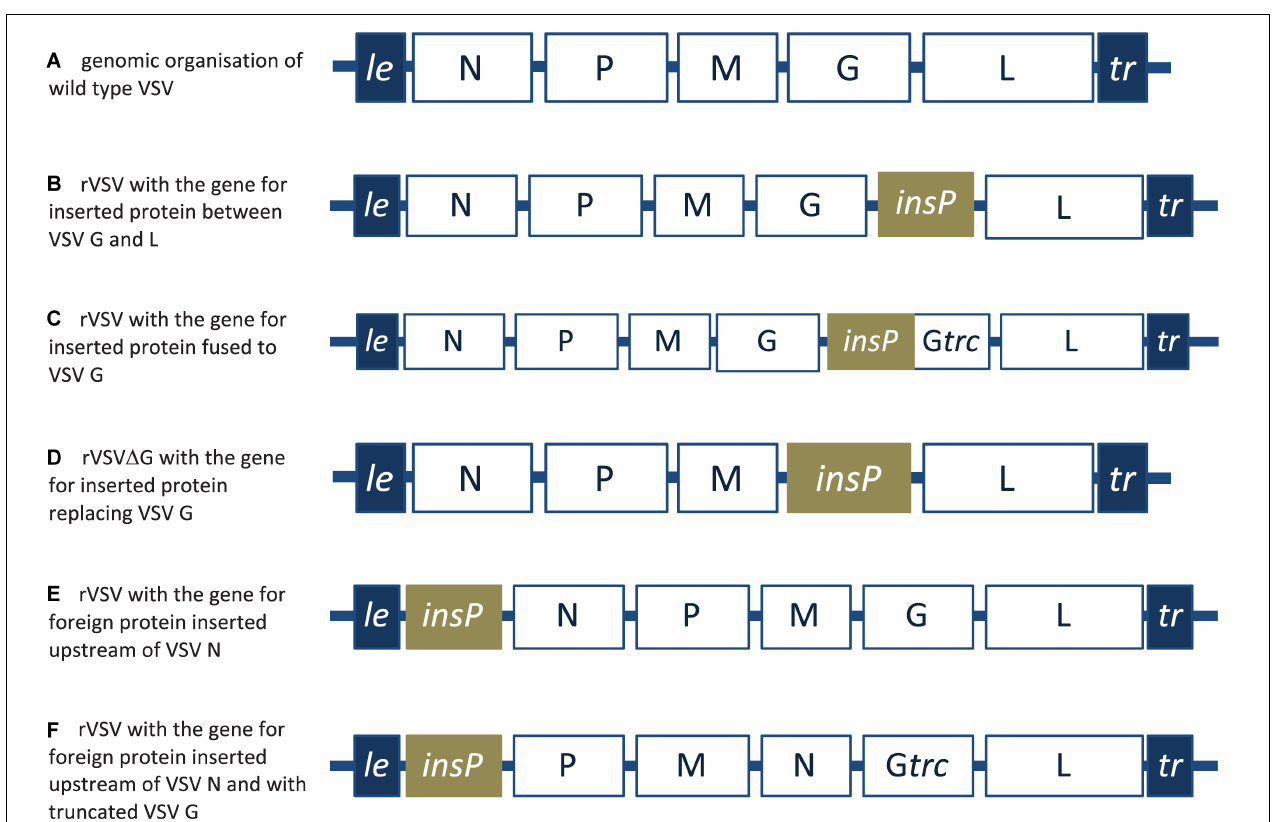
FIGURE 6 | A schematic representation of wild type VSV and recombinant VSV designs. (A) 3 (cid:48) to 5 (cid:48) negative-strand genomic RNA organization of wild type VSV. (B) Recombinant VSV (rVSV) with foreign protein inserted between the VSV G and L genes. (C) rVSV with foreign protein fused to the inherent VSV glycoprotein. (D) Recombinant VSV (cid:49) G with foreign protein replacing the inherent VSV glycoprotein. (E) rVSV with foreign protein gene inserted upstream of the VSV N protein. (F) rVSV with the gene for foreign protein inserted upstream of the VSV N protein and with truncated VSV glycoprotein. le , leader; tr , trailer; insP, gene for inserted protein; Gtrc, truncated glycoprotein.